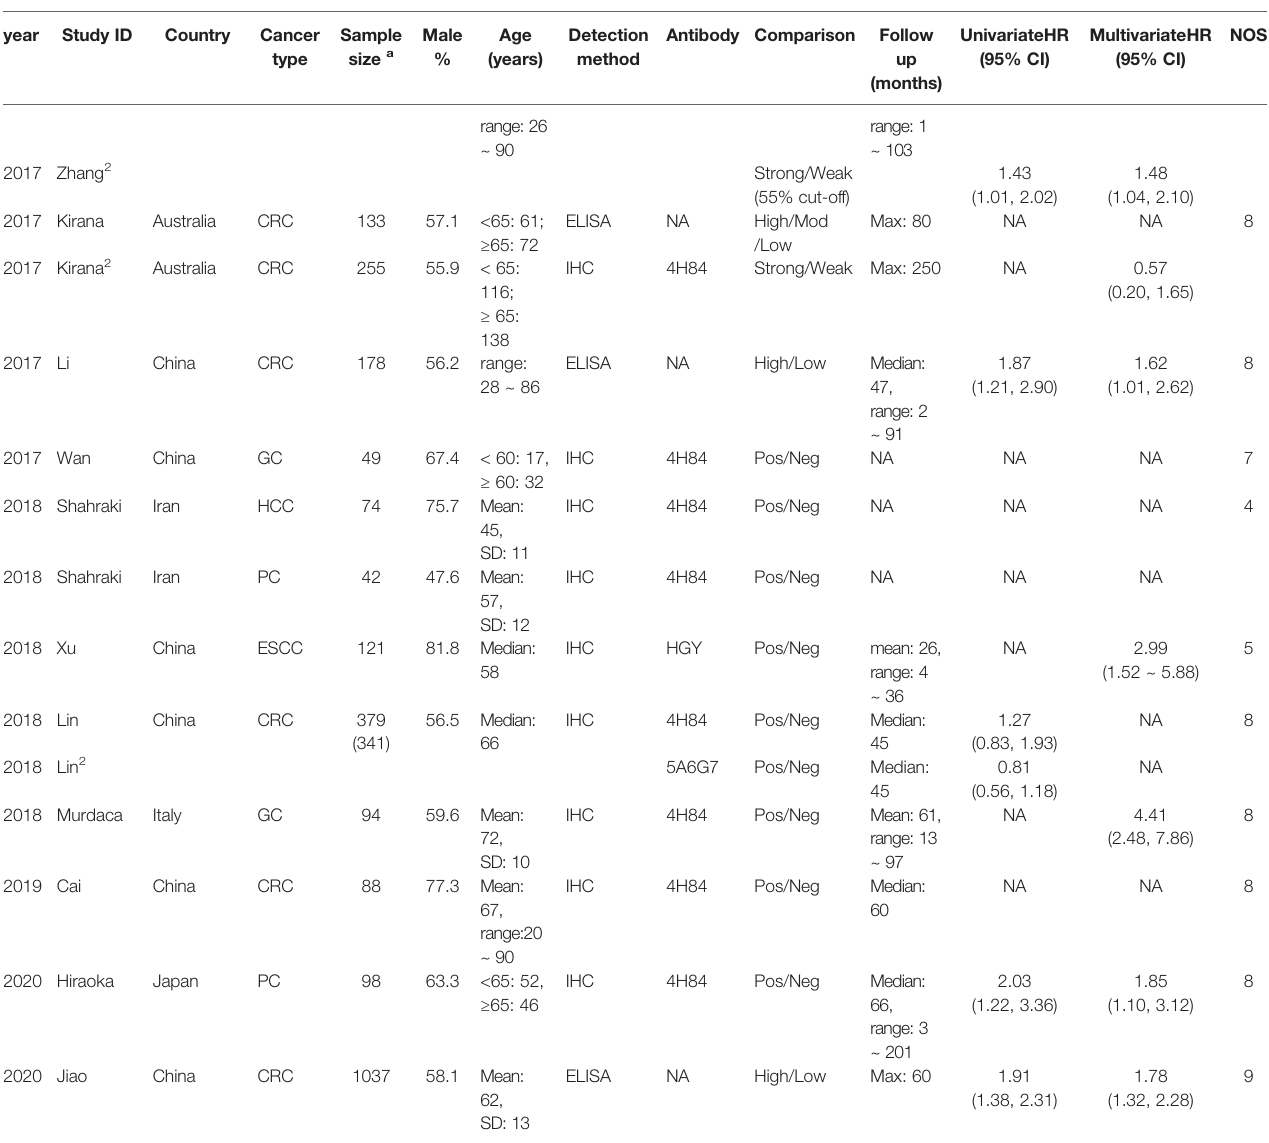
patients. Another fi ve studies (30, 33, 36, 51) divided the HLA-G expression level into two groups (high or low) according to the IHC staining intensity (strong or weak). In the univariate and multivariate analyses, the pooled HRs for HLA-G expression were 1.38 (95% CI: 0.85 ~ 2.24) ( Figure 2E ) and 1.38 (95% CI: 1.01~ 1.89) ( Figure 2F ), respectively. In brief, high/strong HLA- G expression was associated with poor overall survival in patients with GI cancer. Due to the lack of literature with this grouping method, the overall heterogeneity was high.